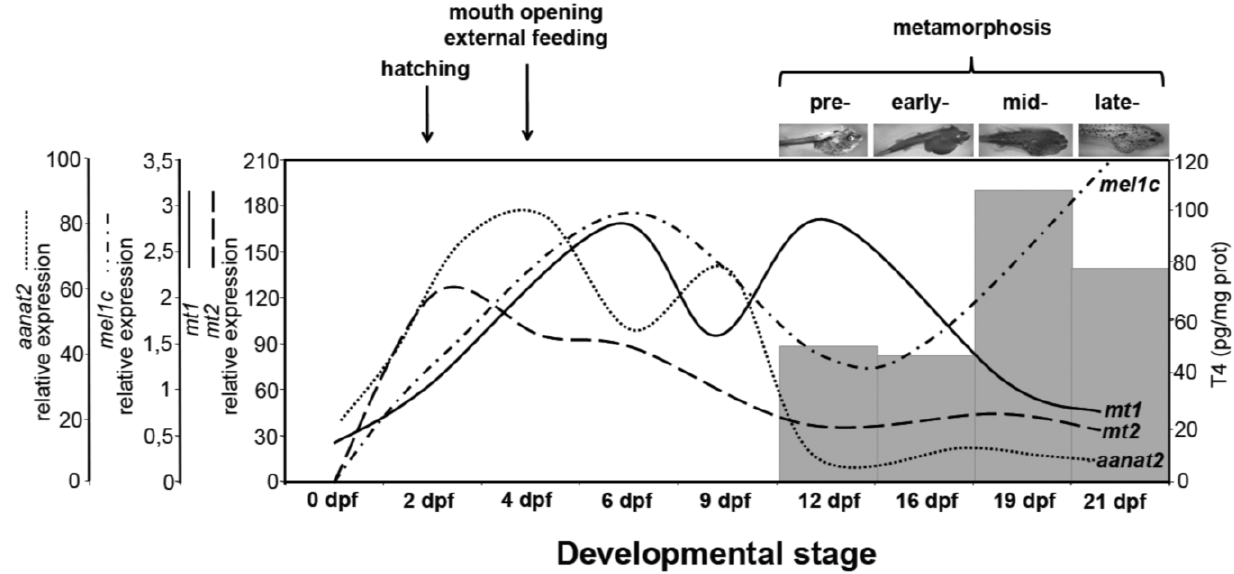
Figure 2. Developmental expression profiles of the three melatonin receptor subtypes ( mt1 , mt2 , mel1c ) and the pineal-specific enzyme arylalkylamine N -acetyltransferase ( aanat2 ) [16], together with thyroid hormone levels (T4, grey columns) [25] in sole. Note that the melatoninergic system is up-regulated at hatching and the onset of external feeding; also note the inverse profile between mt1 , mt2 , and aanat2 expression and thyroid hormone levels during sole development and